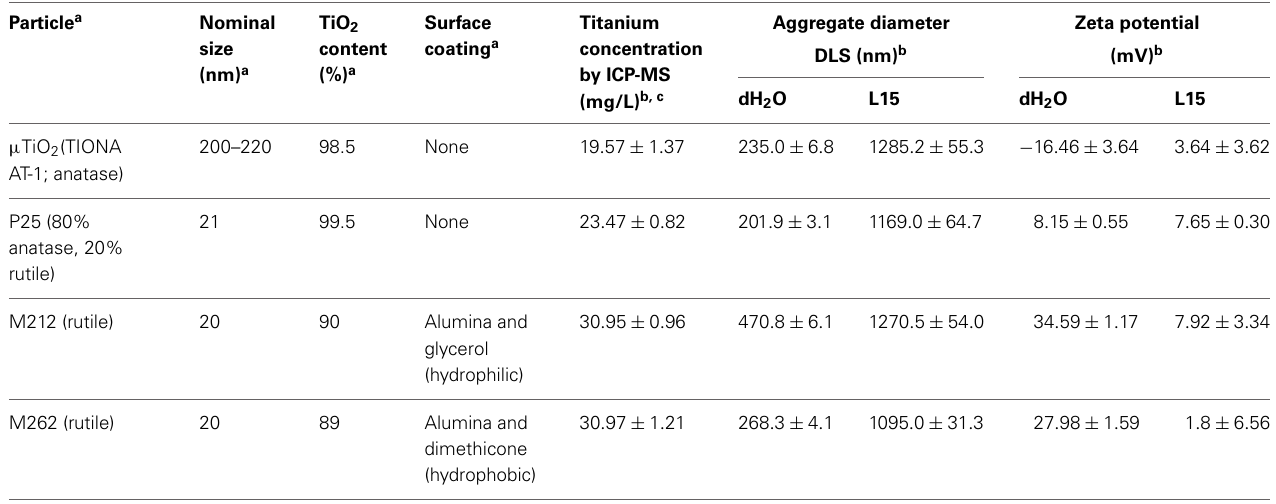
Table 1 | Particle physical parameters and